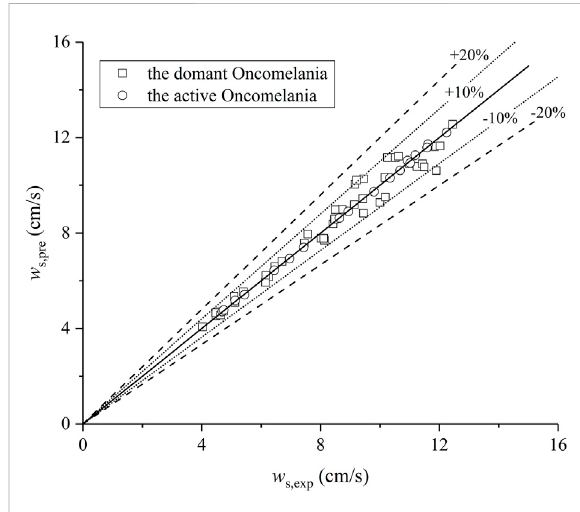
FIGURE 14 Comparison of measured and predicted settling velocity calculated by using explicit terminal settling velocity of Eq.